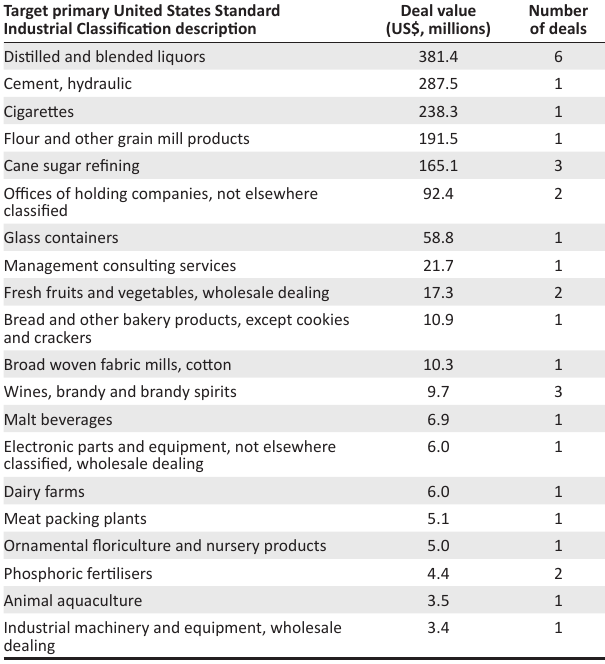
TABLE 11: Agricultural mergers and acquisitions outflows from South Africa by industry activity, 2003–2014.